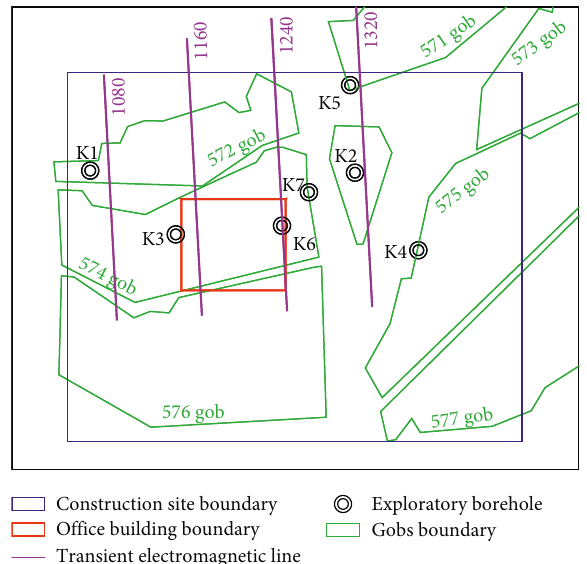
Figure 2: Location of office building, construction site, and old